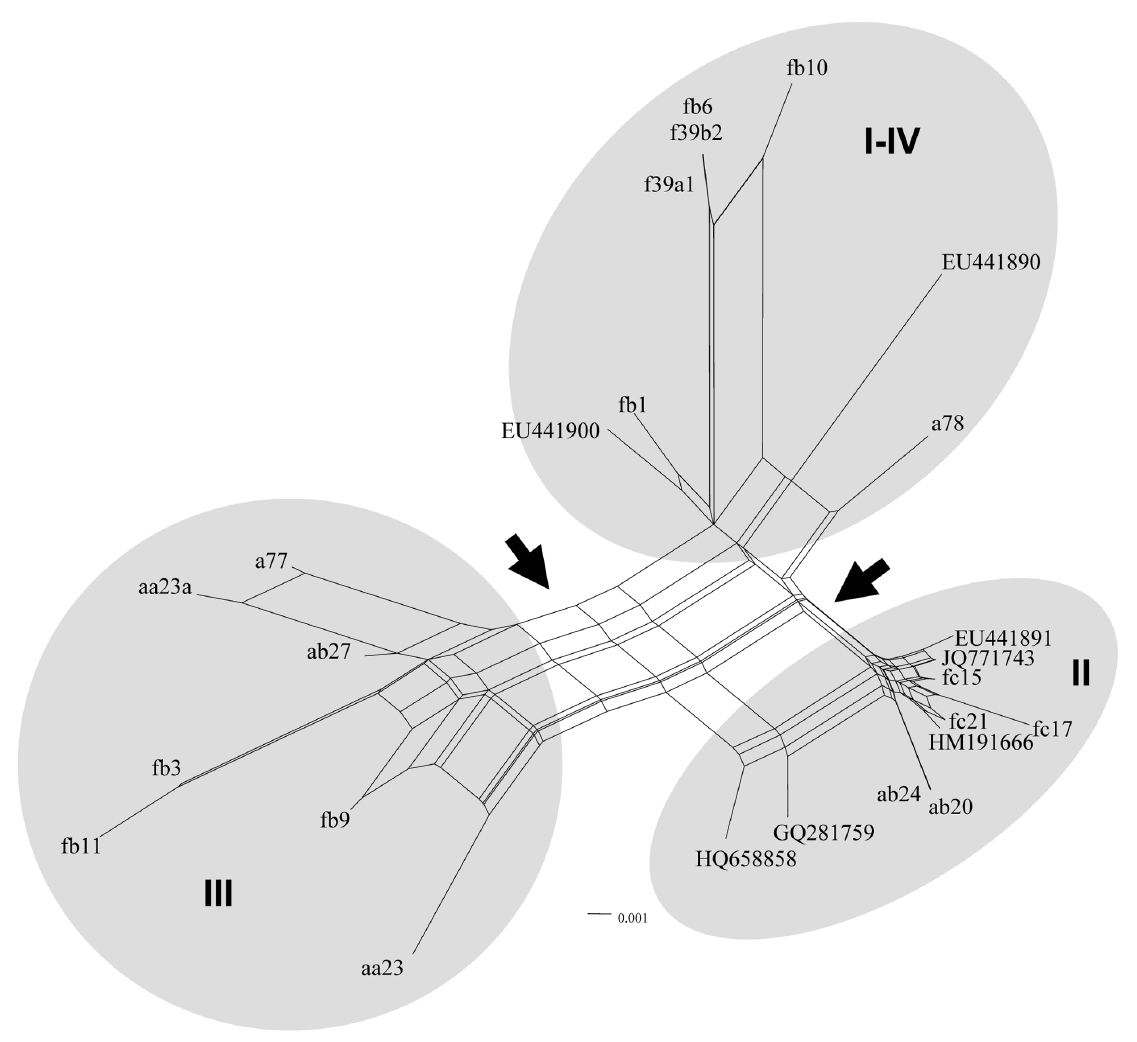
Figure 6. Neighbor-net splits graph of all cloned and database sequences. For display purposes bootstrap scores are not shown. The scale bar represents the split support for the edges. Arrows mark splits separating the three major clusters. Clusters described in the text are denoted by Roman numerals.